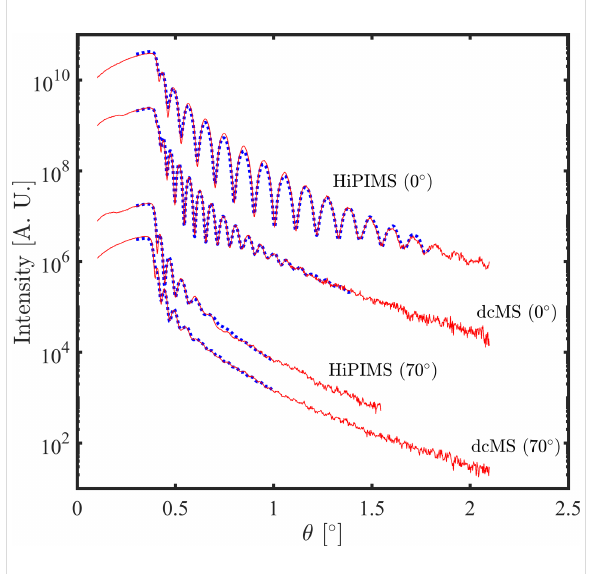
Figure 2: The measured (red solid) and simulated (blue dot) XRR data of HiPIMS and dcMS deposited Ni films under 0- and 70-degrees tilt angles.